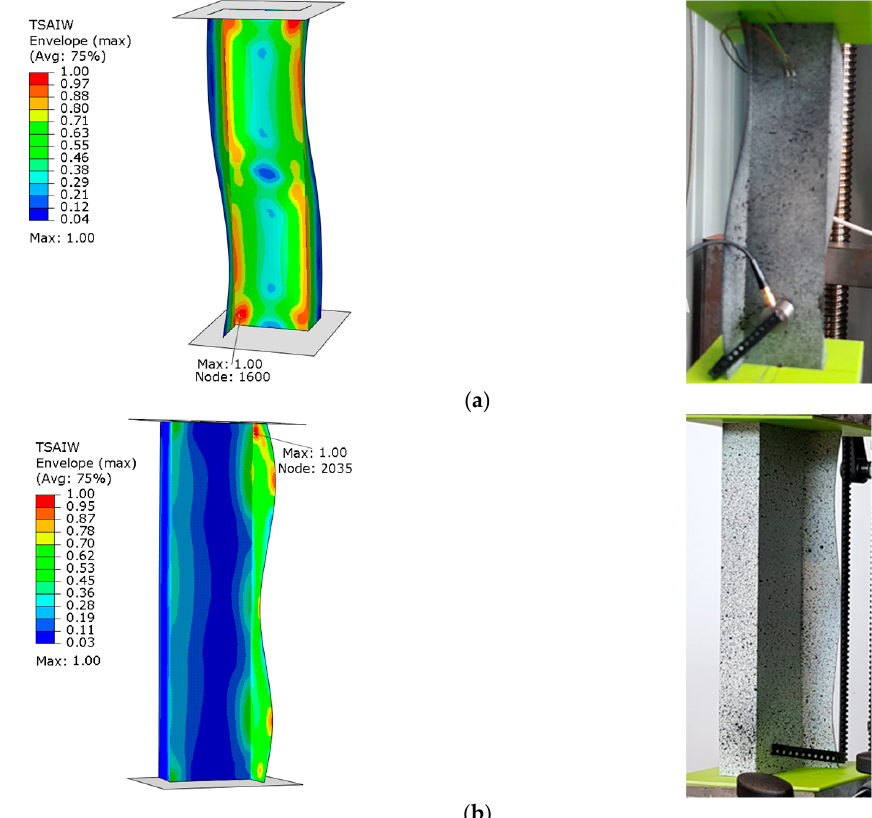
Figure 11. Column z_1—maps of the Tsai–Wu critical parameter and forms of post-critical deformation: ( a ) Test 1 and ( b ) Test 3.